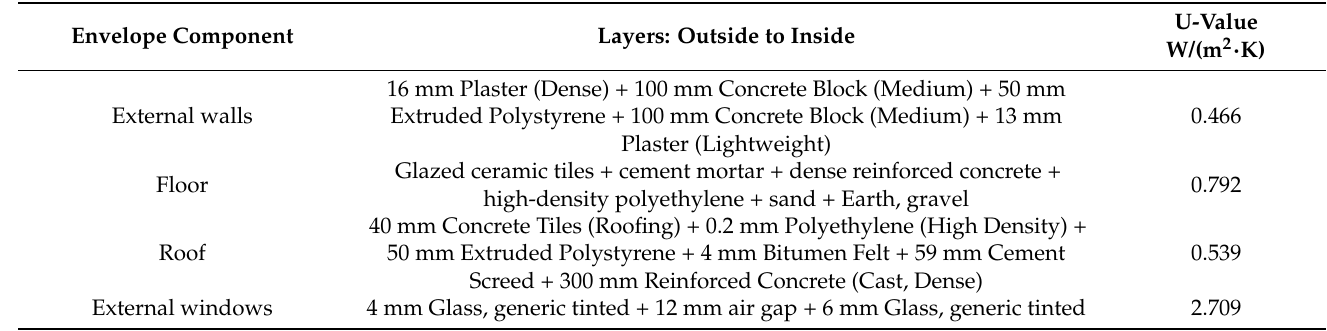
Table 2. Envelope components details [71].